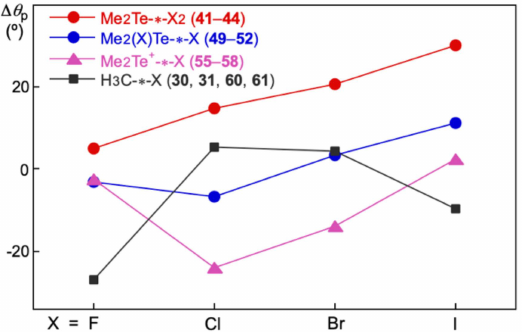
Figure 5. Plots of ∆ θ p versus X (= F, Cl, Br, and I) for Me 2 Te- ∗ -X 2 ( 41 – 44 ), Me 2 (X)Te- ∗ -X ( 49 – 52 ), Me 2 Te + - ∗ -X ( 55 – 58 ), and H 3 C- ∗ -X ( 30 , 31 , 60 , and 61 ) evaluated with